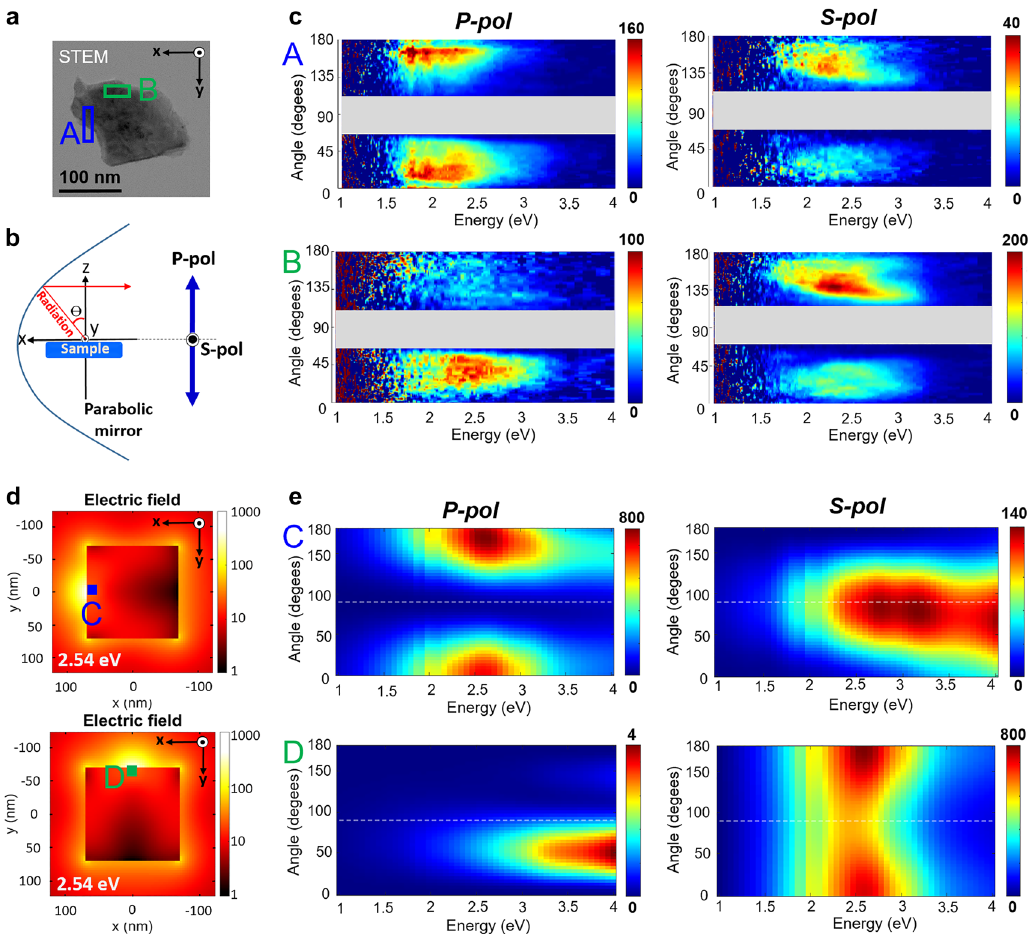
Figure 5: Photon energy and emission angular plots for p and s polarizations. (a) STEM bright-field image of a single MoS 2 nano fl ake with a size of ∼ 160 nm. (b) Schematic illustration of the detection con fi guration. Insertingaslit maskparallelto the z -axisat y =0 helpsobtaintheradiatedsignalsat adetectionanglerangingfrom θ =0 – 180 ° . (c)Measured emissionangularplotsforp-ands-polarizationofthenano fl akeinFigure5a.Thegray-hatchedpartoftheplotaround θ =90 ° ismissingdueto shadowingbythesample.(d)Calculatedtime-averagedelectric fi eldobtainedat E =2.54eV,onasquare fl akewiththesizeof140nm,fortwo excitation points C and D. (e) Simulated angle-resolved spectra for the excitation positions C and D with p- and